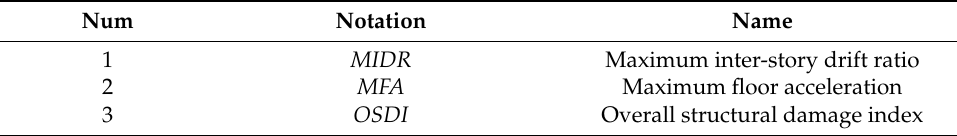
Table 5. Engineering demand parameters considered in the study. Num Notation Name 1 MIDR Maximum inter-story drift ratio 2 MFA Maximum floor acceleration 3 OSDI Overall structural damage